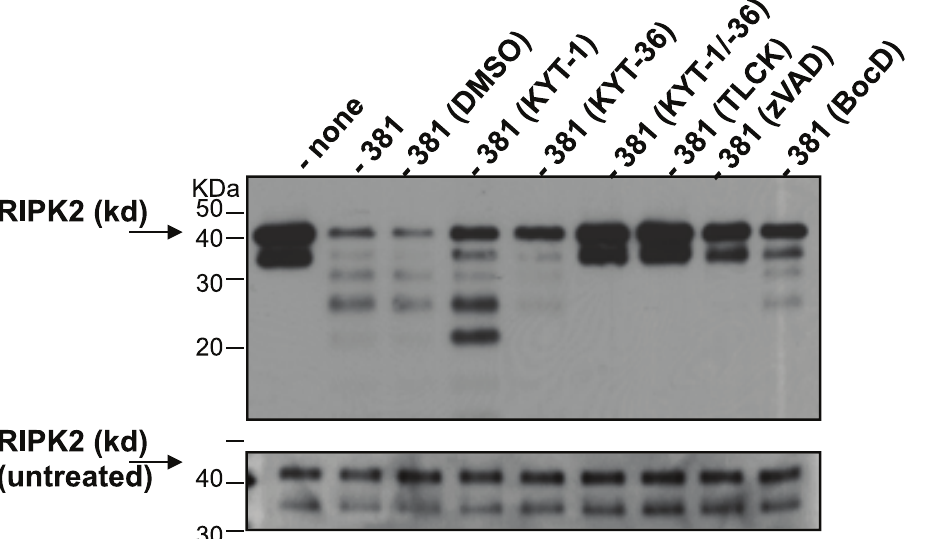
Figure 10. Cleavage of recombinant RIPK2 kinase by P.gingivalis in the absence of host cell proteins. P. gingivalis strain 381 was pretreated with 10 m M KYT-1, 10 m M KYT-36, 10 m M KYT-1 and 10 m M KYT-36, 1 mM TLCK, 100 m M zVAD-fmk, 100 m M BocD-fmk with or vehicle controls (HEPES (none), DMSO or acid water) for 45 min, then immediately co-cultured with 0.1 m g recombinant RIPK2 kinase for 1 h at 37 u C. Reactions were stopped by the addition of SDS-PAGE loading dye and analyzed by Western blot analysis with an antibody to the N 9 -terminal kinase domain of RIPK2. Top panel: reaction with recombinant protein and P. gingivalis ; bottom panel: 10% of reaction prior to incubation with P. gingivalis (untreated recombinant protein, i.e., gel loading